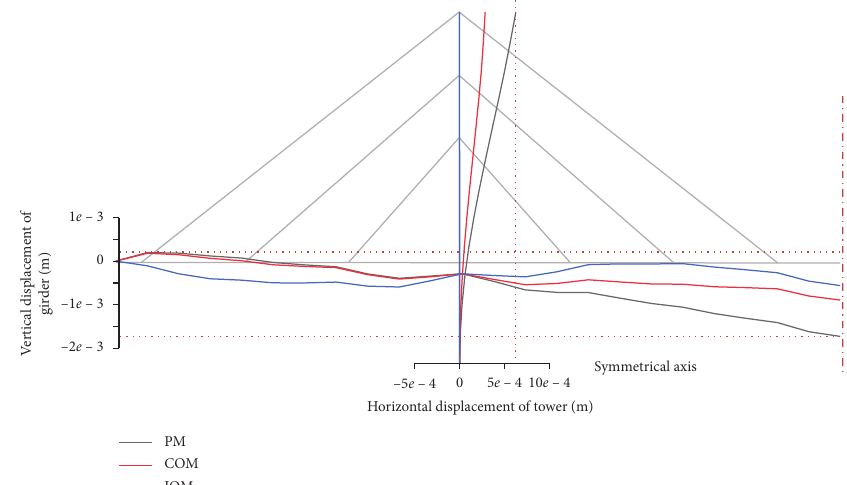
Figure 9: Comparison of displacement of the simple cable-stayed bridge.